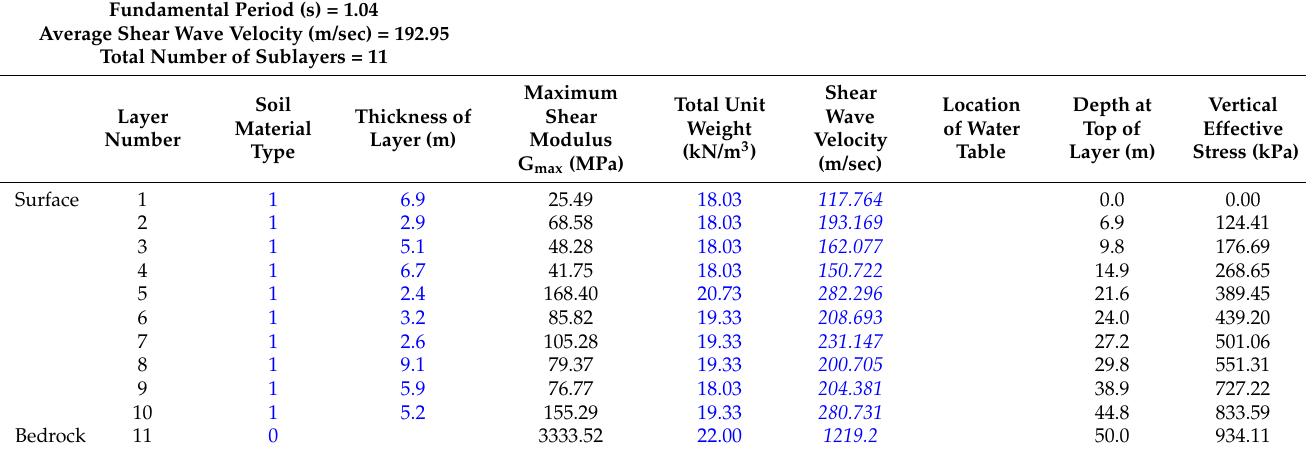
Table 4. Worksheet Profile in NERA for D1